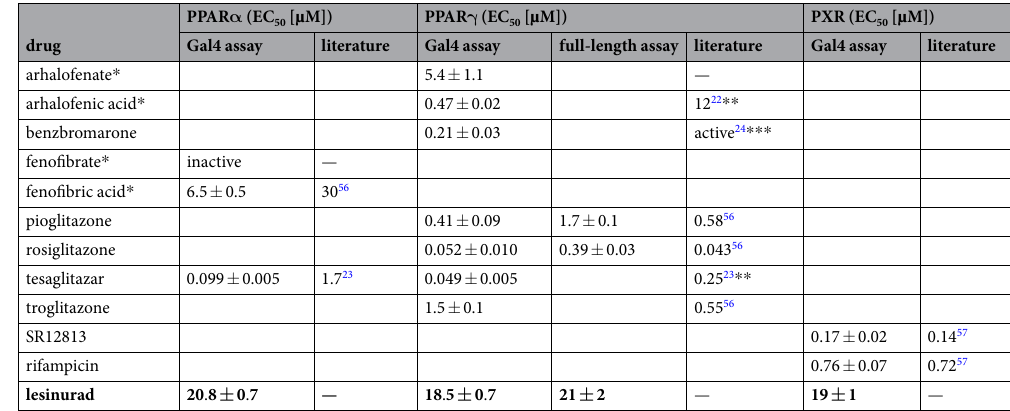
Table 1. In vitro activities of lesinurad and PPAR/PXR activating reference compounds/drugs for comparison. Where available, literature values refer to reporter gene assays similar to our test systems. However, there are differences concerning incubation times and used cell lines that may affect observed activities. Results are mean ± SEM of at least three independent experiments. * Arhalofenate and fenofibrate are prodrugs with arhalofenic acid and fenofibric acid as active metabolites. ** Literature values of arhalofenic acid and tesaglitazar refer to murine PPAR γ . *** No precise activity value has been reported for benzbromarone on PPAR γ .